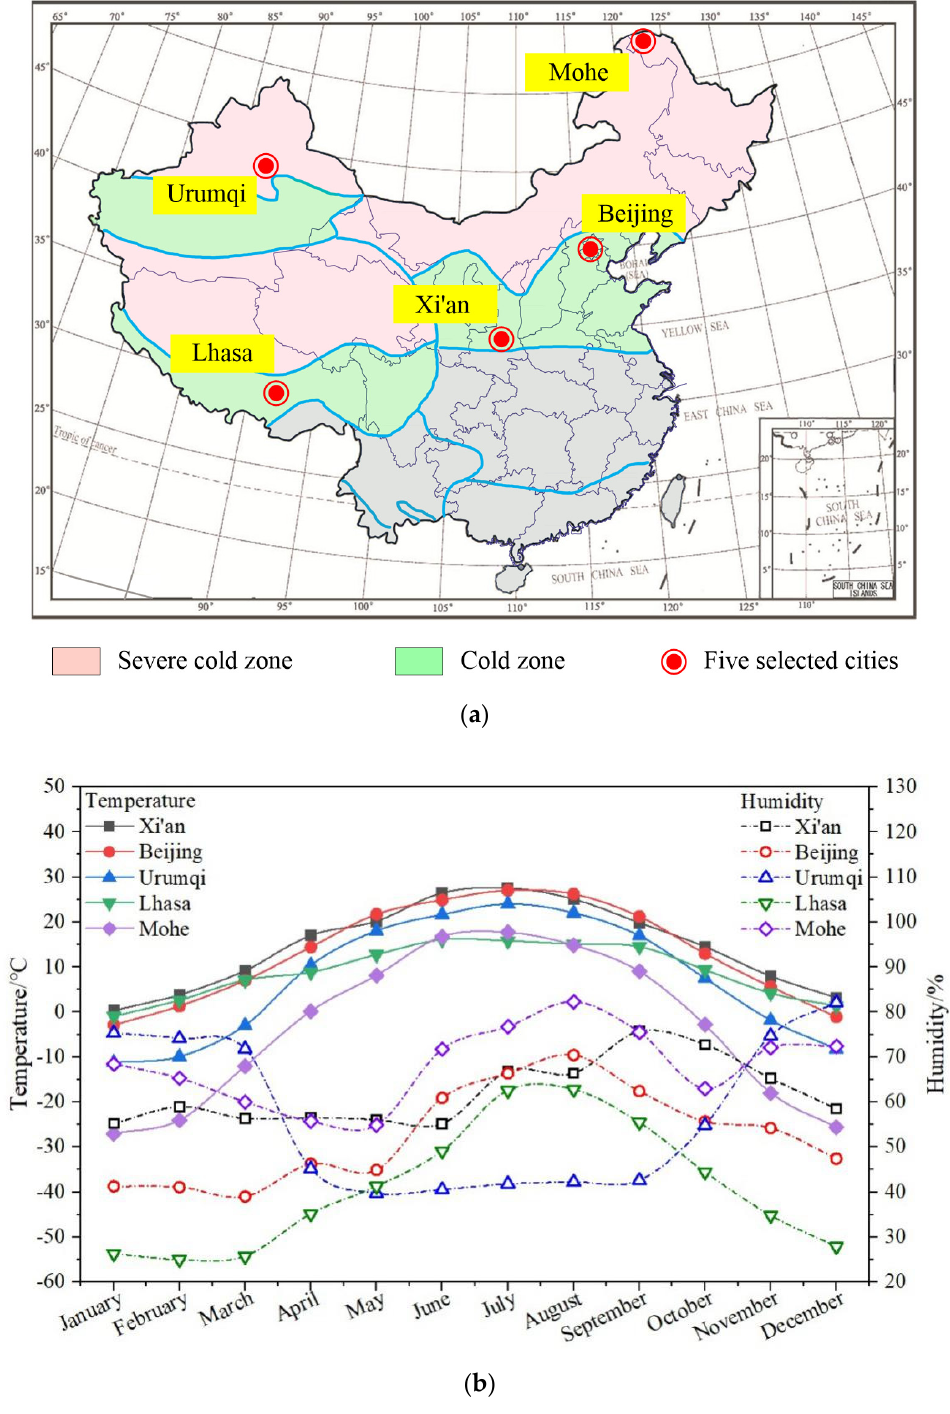
Figure 5. Climate characteristics of the five selected cities: ( a ) Locations of five selected cities; ( b ) Average temperature and humidity values in TMY.